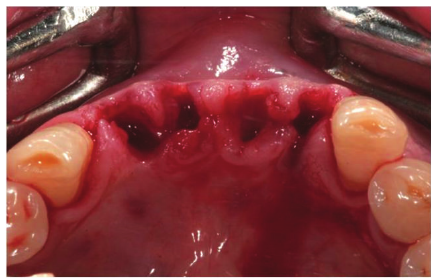
Figure 3: Dental extractions.